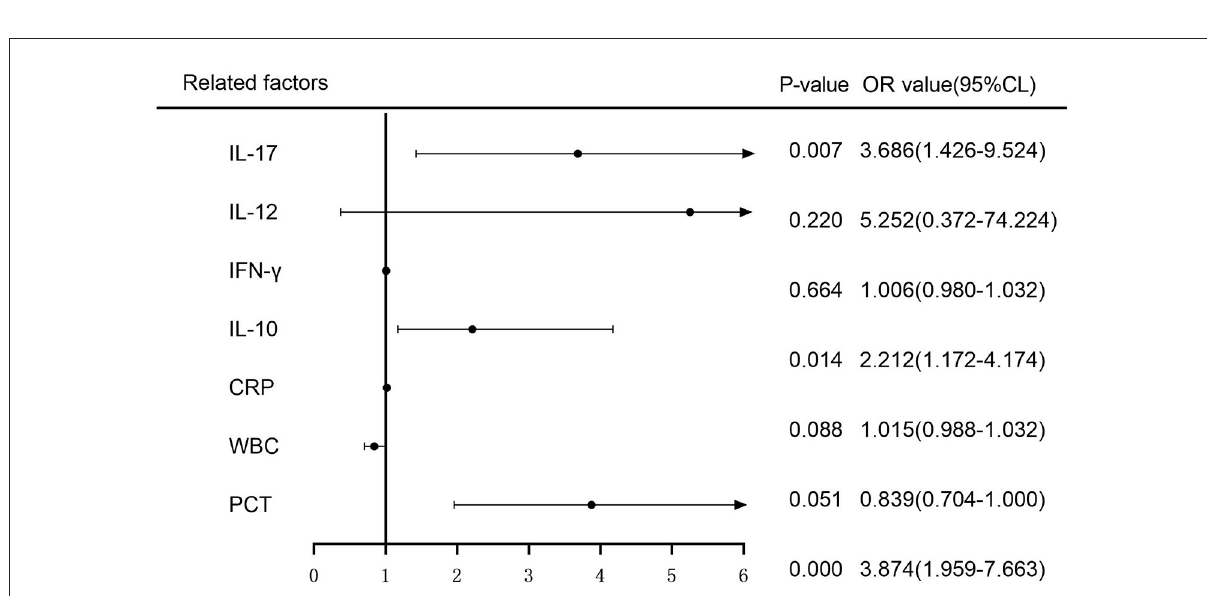
FIGURE2 Multifactorial logistic regression analysis of the risk of sepsis development forest plot.